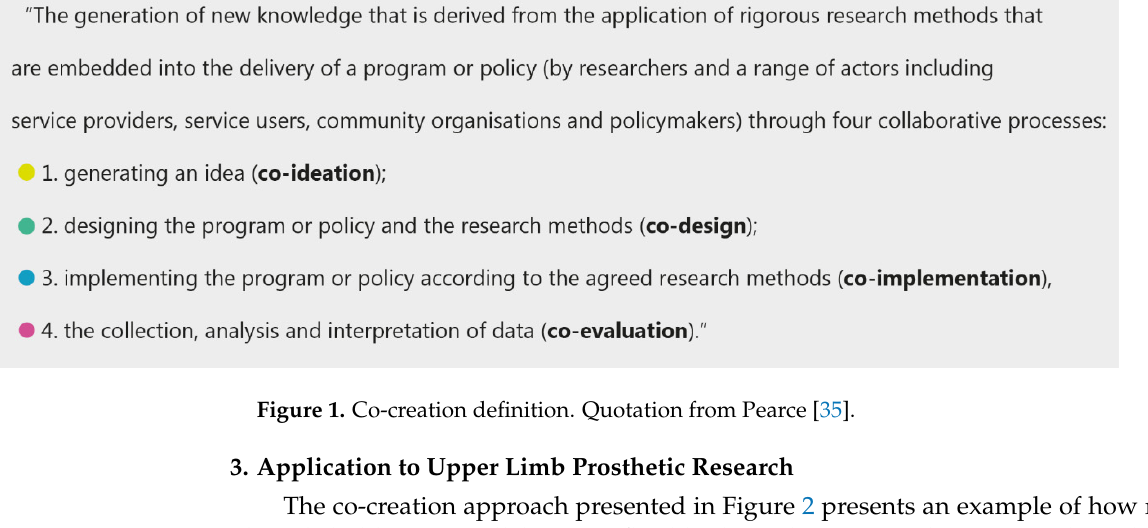
Figure 1. Co-creation definition. Quotation from Pearce [35].